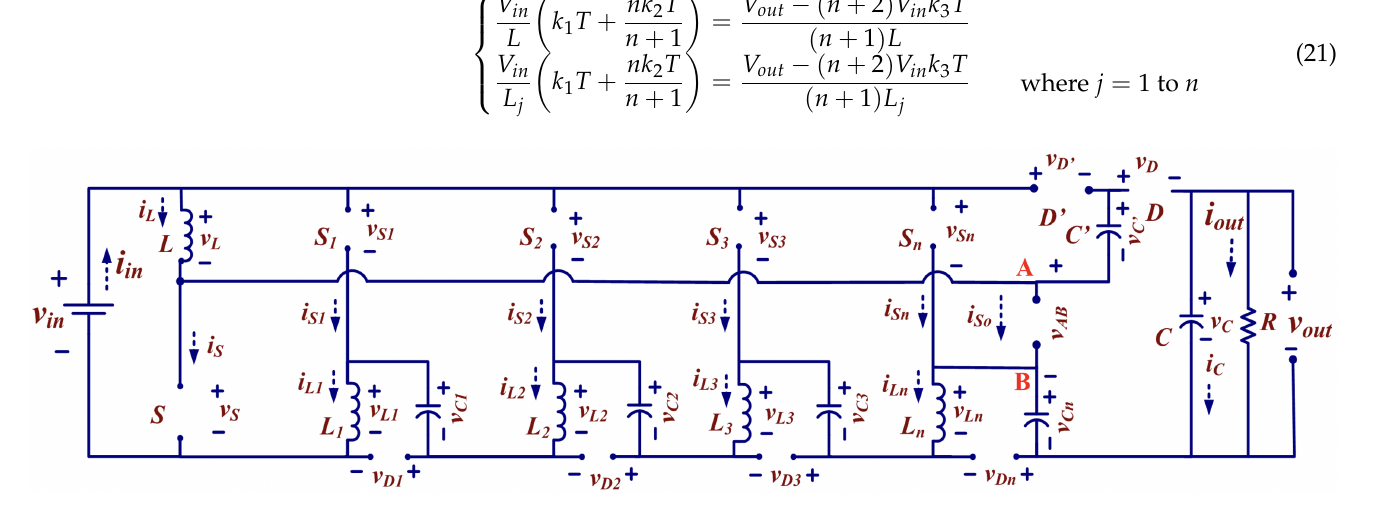
Figure 6. ML converter in